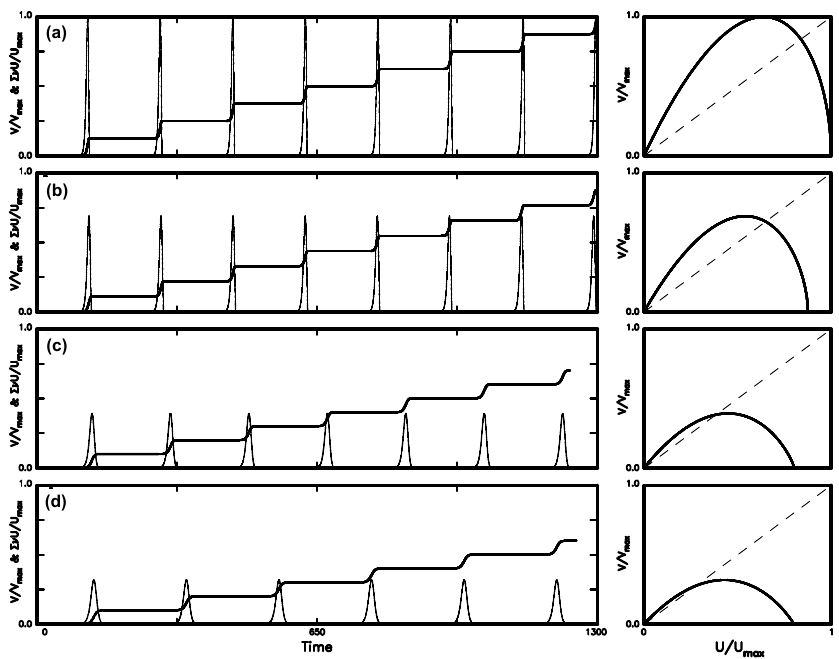
Figure 7. The time variations in V/V max (thin solid line) and cumulative slip (cid:54)U/U max (solid line) and the phase portrait of V/V max versus U/U max (solid line) for four values of η : (a) for η = 0.2; (b) for η = 0.4; (c) for η = 0.8; and (d) for η = 1.0 when U c =